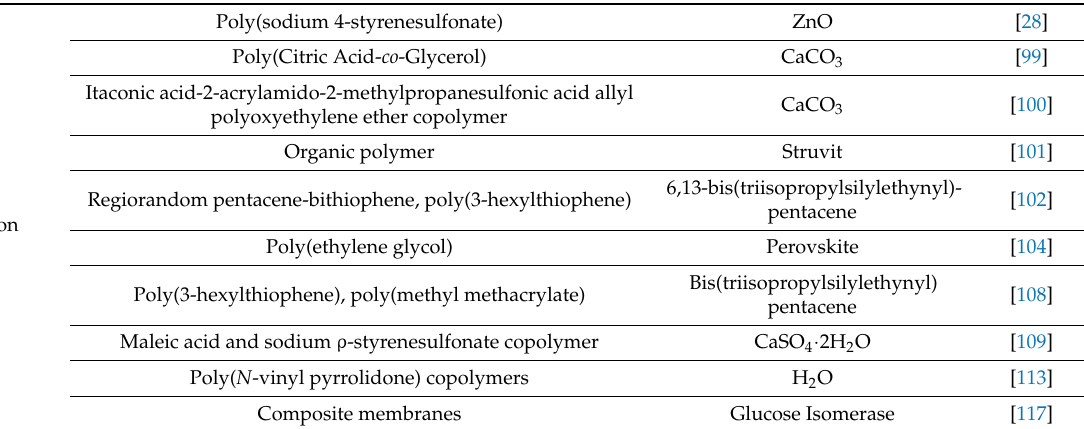
Crystal surface